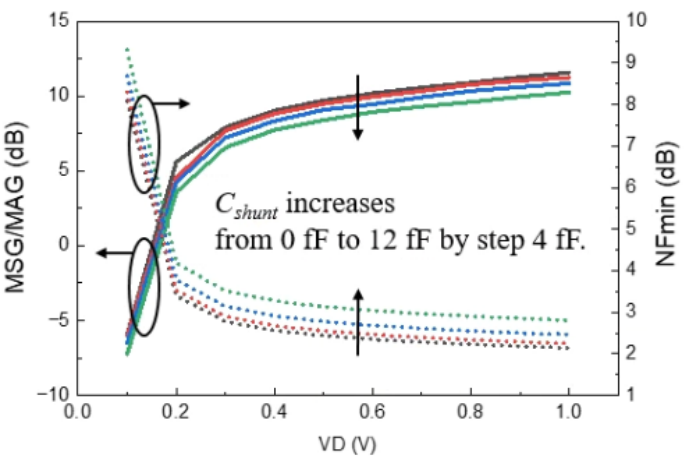
Figure 3. Maximum stable/available gain (MSG/MAG) and NF min depending on drain voltage (VD) at 77 GHz .